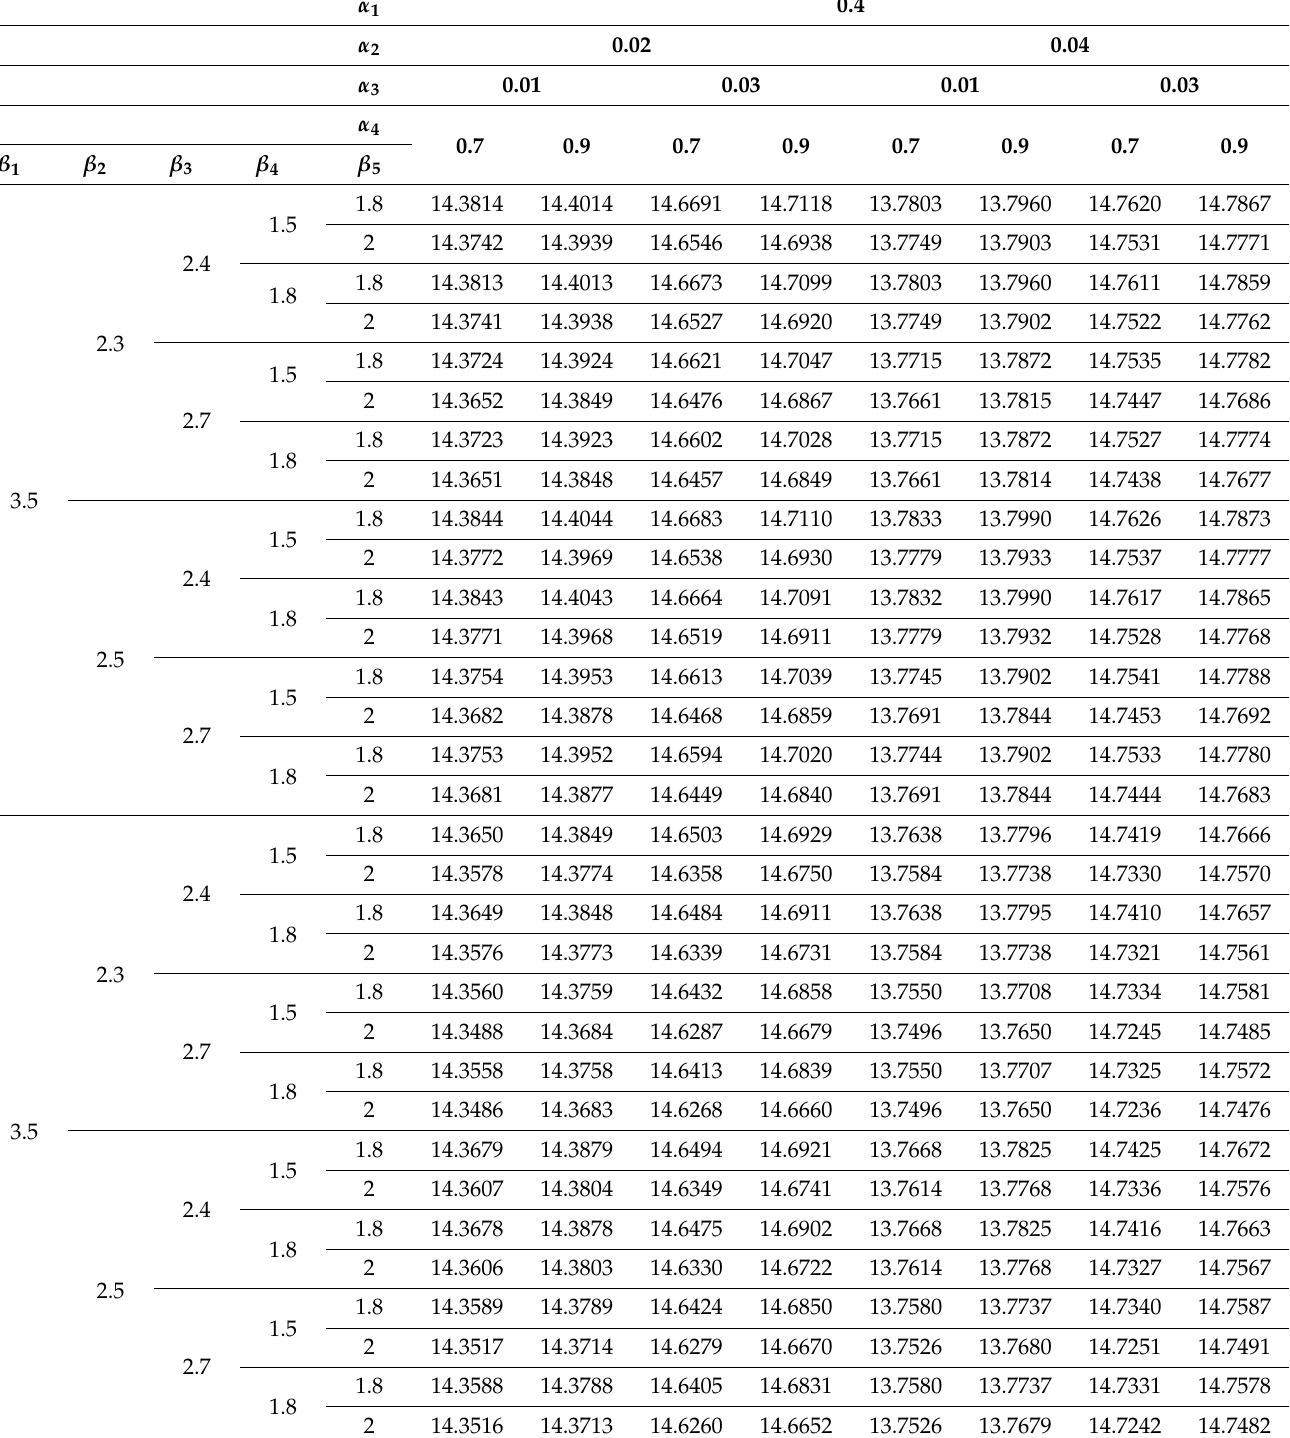
Table 3. Interpretation of parameters on E TCV